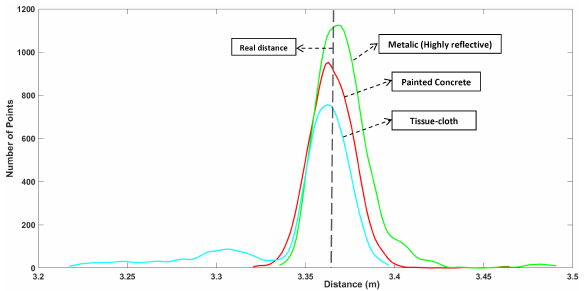
Figure 3. Variation of distance measurement with respect to different materials